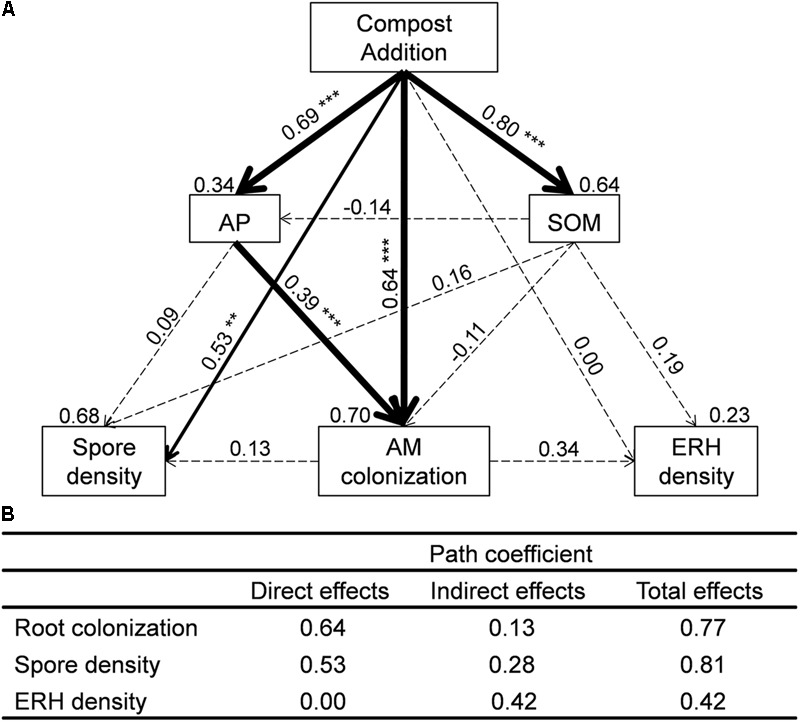
(A) Structural equation models (SEMs) showing the direct and indirect effects of compost addition on arbuscular mycorrhizal (AM) colonization, spore density, and extraradical hyphal (ERH) density. Values above the line represent the path coefficients. Values above the text box represent the residuals. Solid and dashed lines indicate significant and non-significant pathways, respectively. Width of arrows indicates strength of the standardized path coefficient (∗∗∗P < 0.001; ∗∗P < 0.01; ∗P < 0.05). (B) Impact of compost addition on AM root colonization, spore density, and ERH density assessed by SEM including direct, indirect, and total effect coefficients based on hypothesized causal relationships. SOM, soil organic matter; AP, available phosphorus.